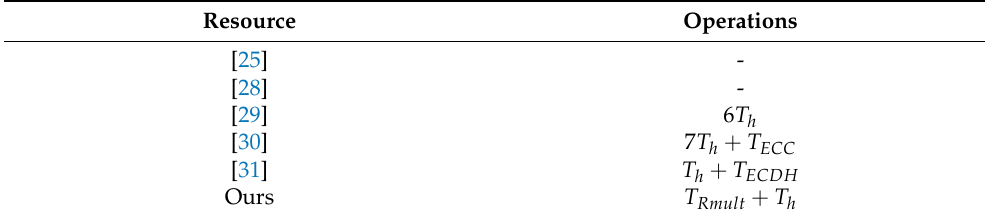
Table 7. Comparison of operations made by the IoT device.